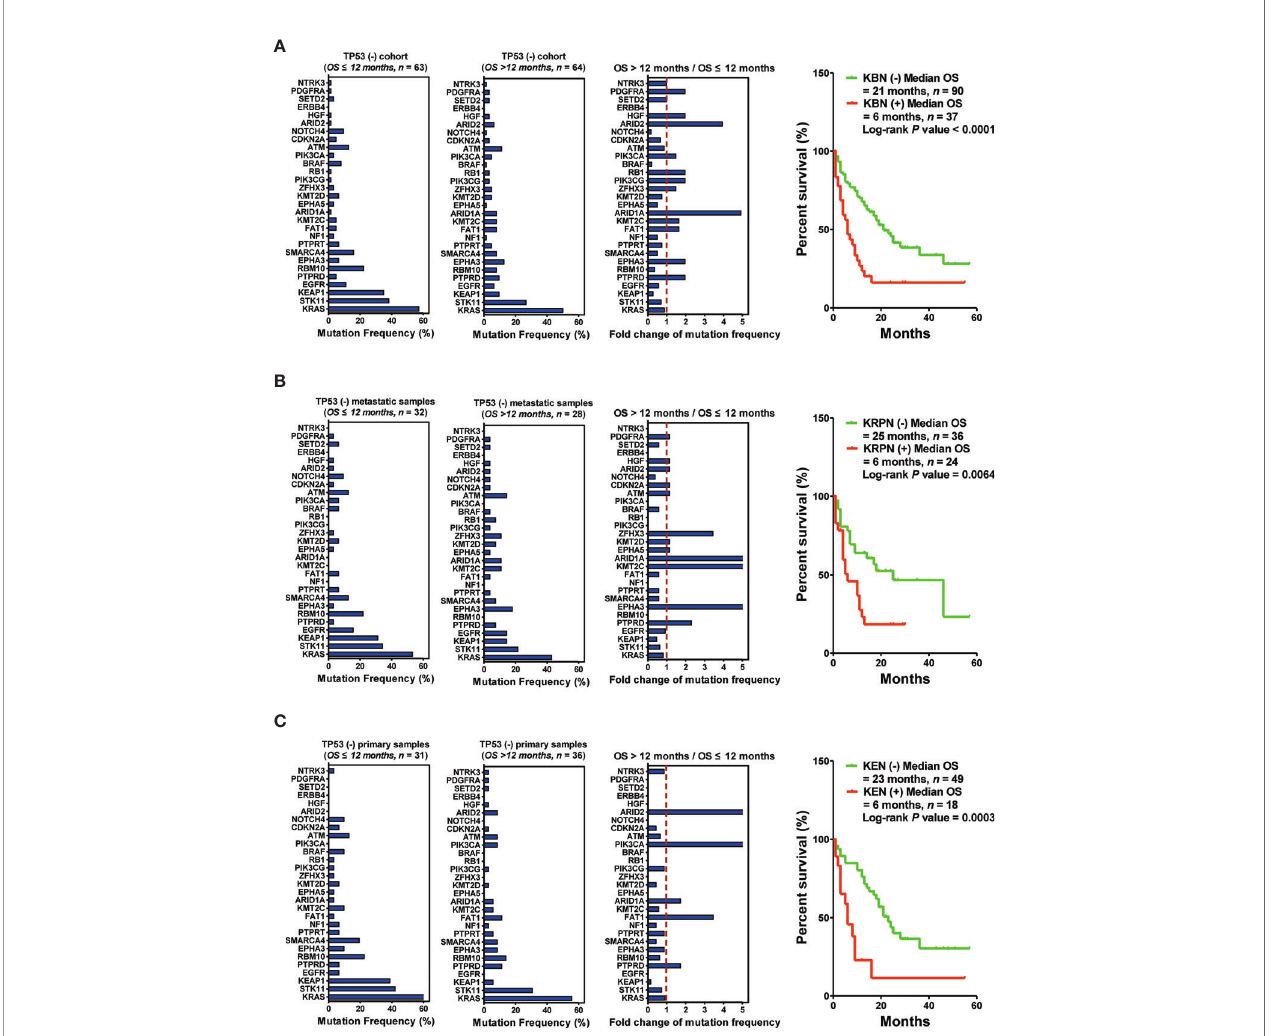
FIGURE 5 | Biopsy lesion type affects the stratifying factors of immunotherapy in patients without TP53 (+) mutation. (A) Left: Mutation frequency of the top 30 genes in the TP53 ( − ) cohort with OS ≤ 12 months. Mutation frequency of the top 30 genes in the TP53 ( − ) cohort with OS >12 months. Fold change in mutation frequency with OS >12 months/OS ≤ 12 months for the top 30 genes. Right: Kaplan – Meier curve analysis of OS strati fi cation using the KBN ( KEAP1 , BRAF , and NOTCH4 ) mutation status. (B) Left: Mutation frequency of the top 30 genes in the TP53 ( − ) metastatic sample cohort with OS ≤ 12 months. Mutation frequency of the top 30 genes in the TP53 ( − ) metastatic sample cohort with OS >12 months. Fold change in mutation frequency with OS >12 months/OS ≤ 12 months for the top 30 genes. Right: Kaplan – Meier curve analysis of OS strati fi cation using the KRPN ( KEAP1 , RBM10 , PIK3CA , and NOTCH4 ) mutation status. (C) Left: Mutation frequency of the top 30 genes in the TP53 ( − ) primary sample cohort with OS ≤ 12 months. Mutation frequency of the top 30 genes in the TP53 ( − ) primary sample cohort with OS >12 months. Fold change in mutation frequency with OS >12 months/OS ≤ 12 months for the top 30 genes. Right: Kaplan – Meier curve analysis of OS strati fi cation using the KEN ( KEAP1 , EGFR , and NOTCH4 ) mutation